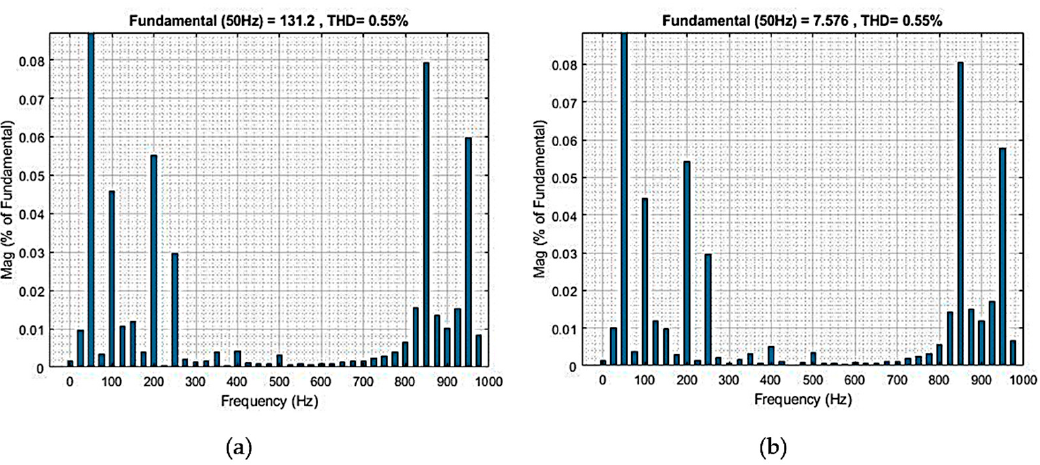
Figure 11. The THD values of output voltage and current for the 3-phase inverter interfaced with HS-SZSC, ( a ) voltage waveform, and ( b ) current waveform.